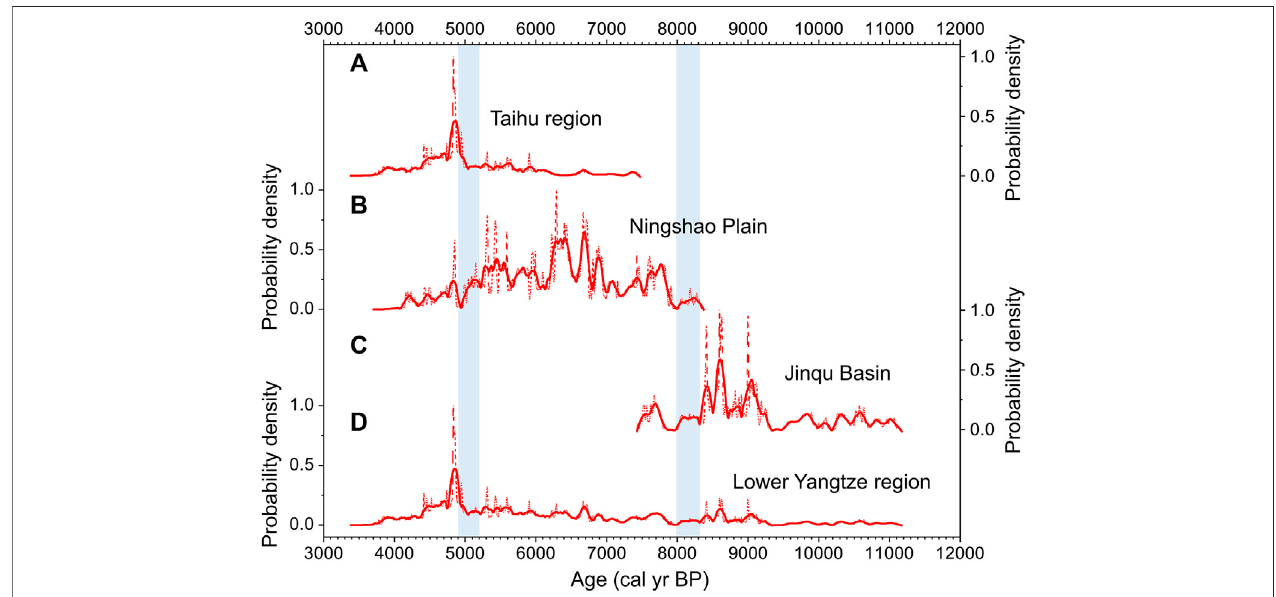
FIGURE 4 | Summed probability distributions (SPD) of the archaeological radiocarbon dates in the lower Yangtze region. (A) Taihu region. (B) Ningshao Plain. (C) JinquBasin. (D) LowerYangtzeregion.DottedcurvesshowtheSPDresultsandsolidlinesshowthe200-point-smoothingoftheSPDresults.Bluebandsshowtheshift periods of core areas of population.